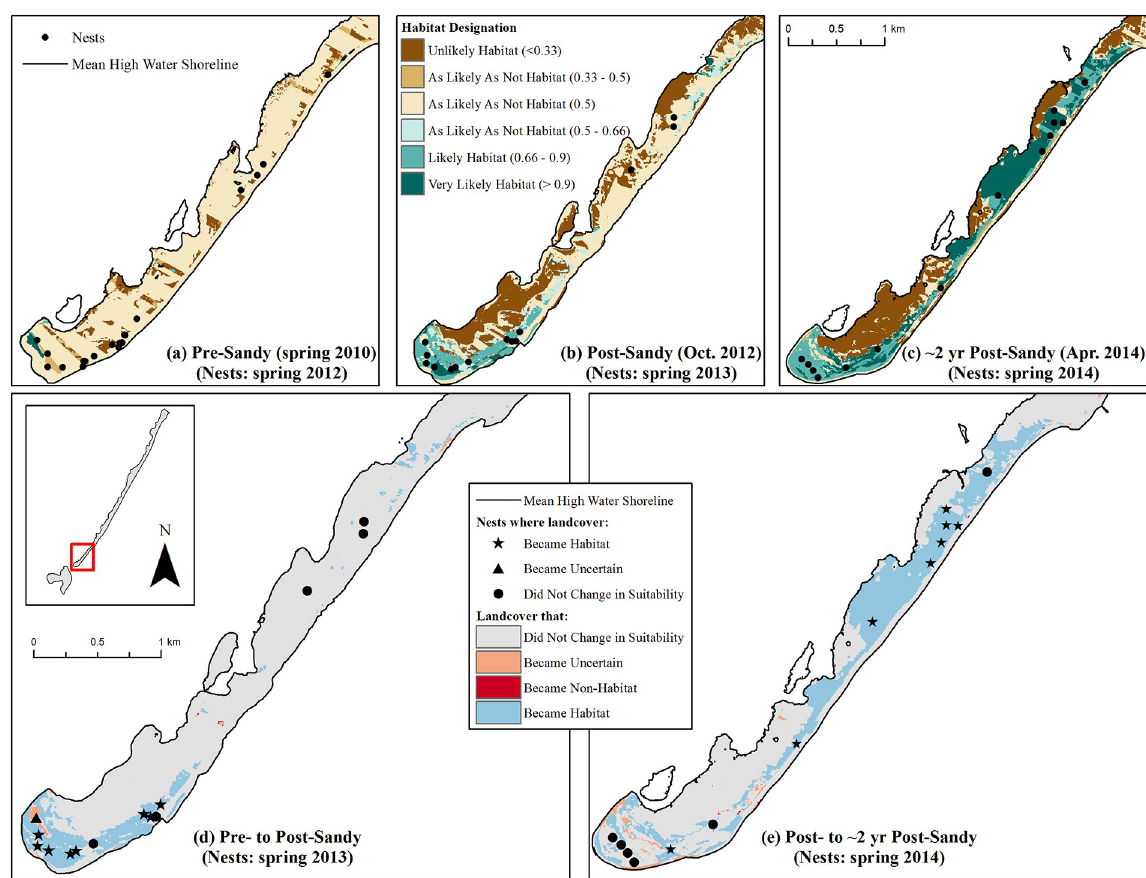
Fig 7. Examples of habitat change before Hurricane Sandy, immediately following Sandy, and ca. 2 years post-Sandy in the Holgate Unit of the Edwin B. Forsythe National Wildlife Refuge on Long Beach Island, New Jersey. Maps (a)-(c) show habitat in the year corresponding with the aerial imagery used for analysis, with piping plover nest points corresponding to the breeding season for which habitat was available 1 . Map (d) shows changes in habitat that ostensibly resulted from Hurricane Sandy, while map (e) shows changes in habitat since the hurricane occurred 2 . 1 Nest points contributed by [67]. 2 See footnotes accompanying Fig